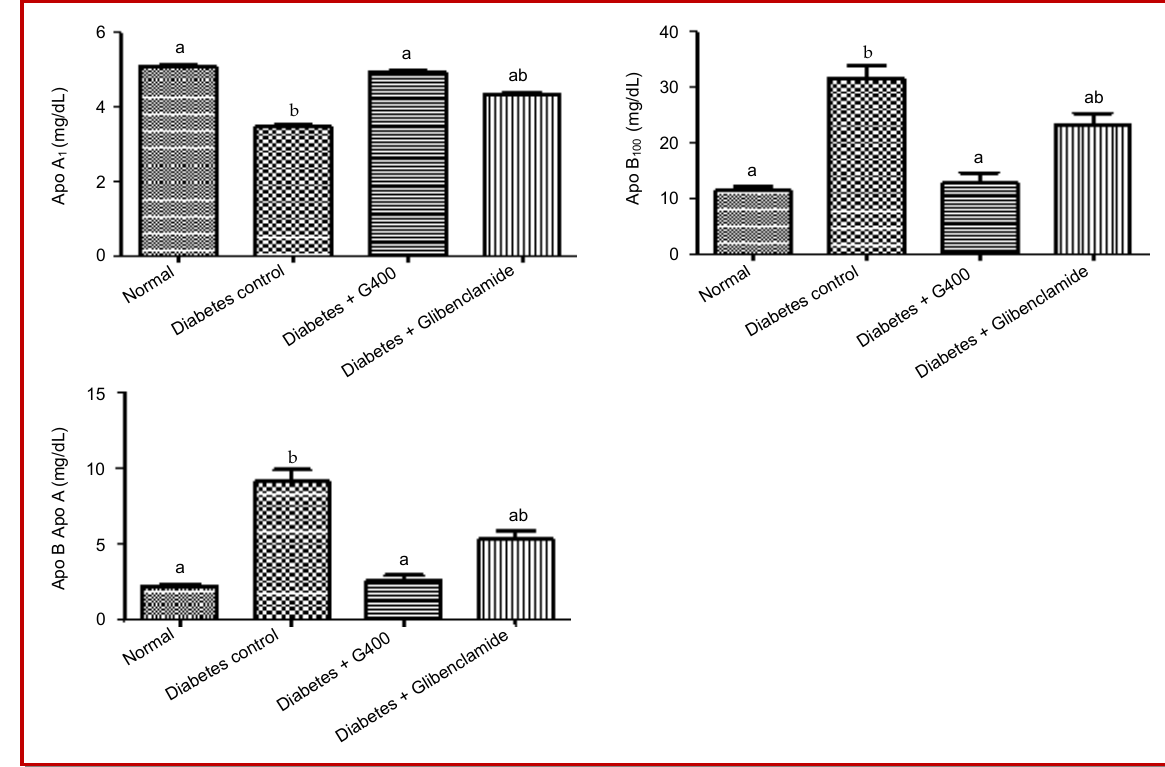
Figure 3: Effect of G-400 on apo A1, apo B100 and apo A1/apo B100 levels in blood samples Streptozotocin-treated diabetic rats were treated with G-400 (100 mg/kg b.wt.) daily using an intragastric tube for 4 weeks. The results were com- pared with diabetic control rats (group 2) and normal control (group 1), where no streptozotocin was administered. The positive control in the study comprises of rats administered with glibenclamide (0.025 mg/kg b.wt.) daily using an intragastric tube for 4 weeks. Results are expressed as mean ± SD of n = 4-6 independent assays. bp<0.05, statistically different from the control group, ap<0.05, statistically different from diabetic